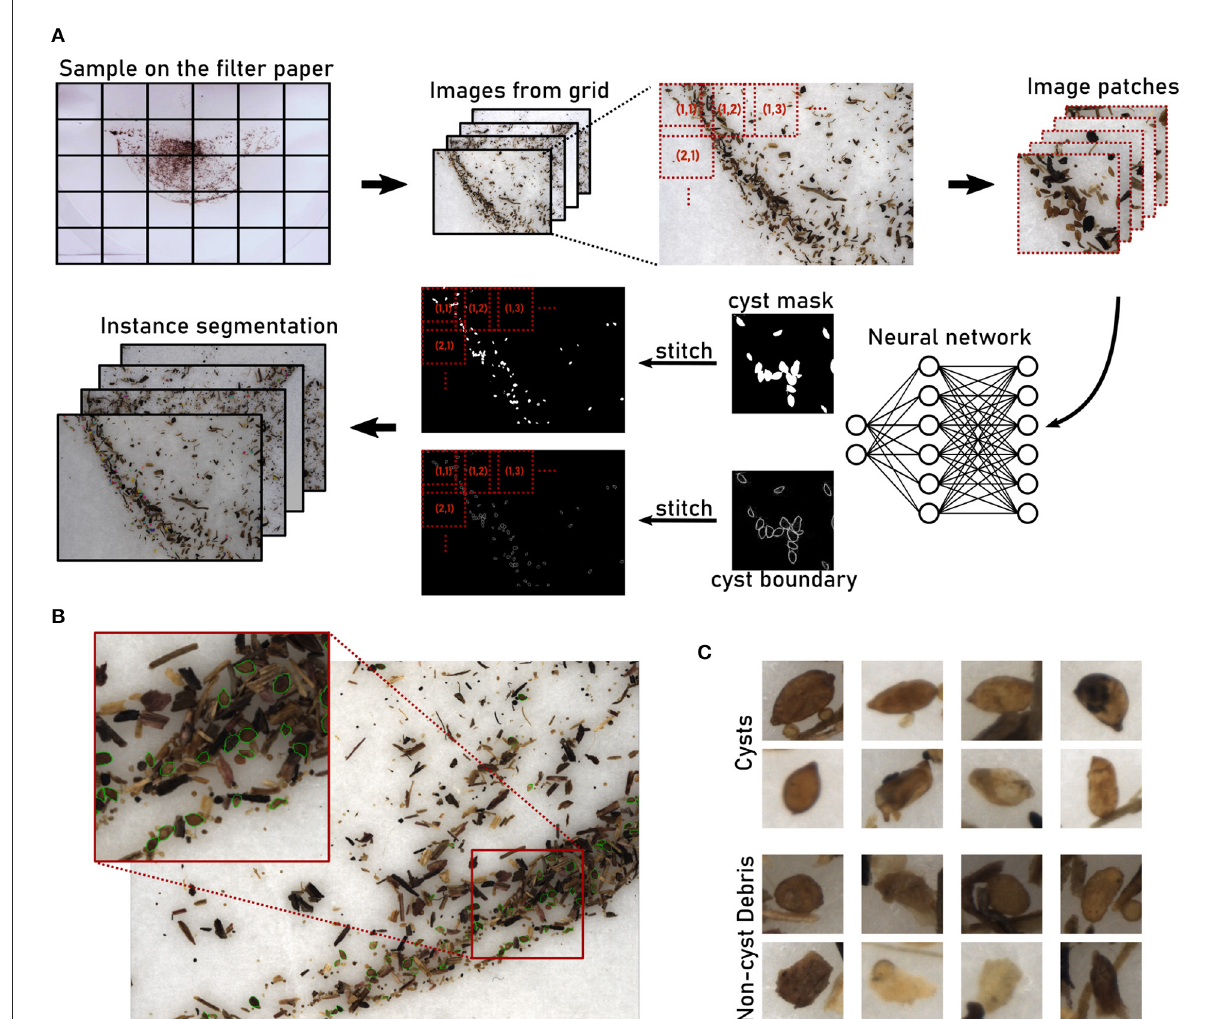
FIGURE1 Computer vision pipeline for instance segmentation of nematode cysts. (A) A high-resolution image is partitioned into tiles that are processed separately. For each image tile, patches are processed by the neural network to generate cyst and boundary masks. Stitching the tile-level masks together results in whole-image masks that are further processed to obtain the final instance segmentation (Methods). (B) Microscopical image of a soil sample extract containing nematode cysts (annotated in green) and organic debris particles. (C) Examples for nematode cysts and debris particles that resemble the